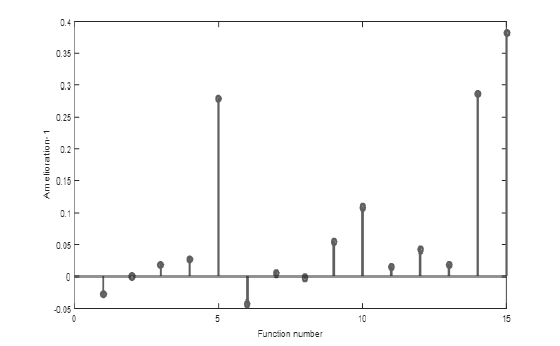
Figure 3(b). Illustration of the amelioration rate values related to PSO for each function shifted to